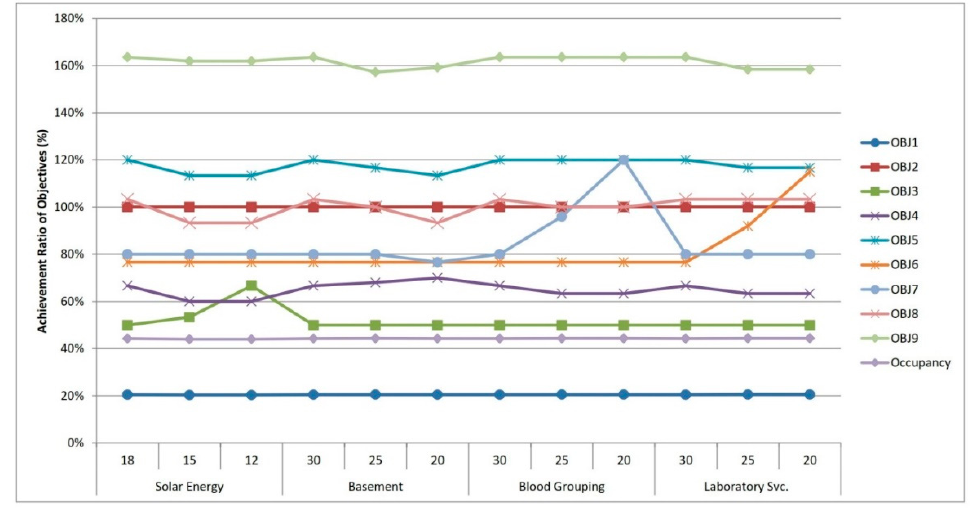
Figure 10. Achievement ratios for objectives as a result of conducting sensitivity analyses regarding availability factors.